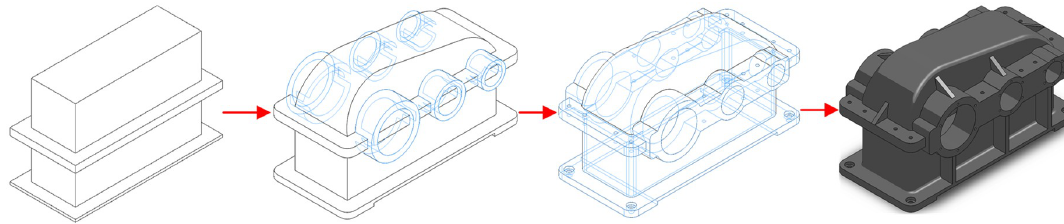
Figure 3. Steps from the digitizing process of the housing and cover in SOLIDWORKS as a single body.